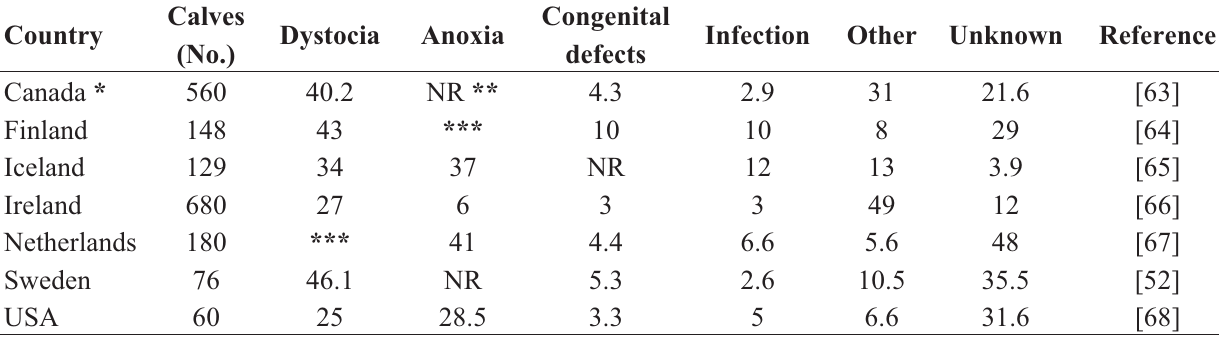
Table 2. Necropsy-diagnosed causes of death (%) for calves dying in the neonatal period internationally